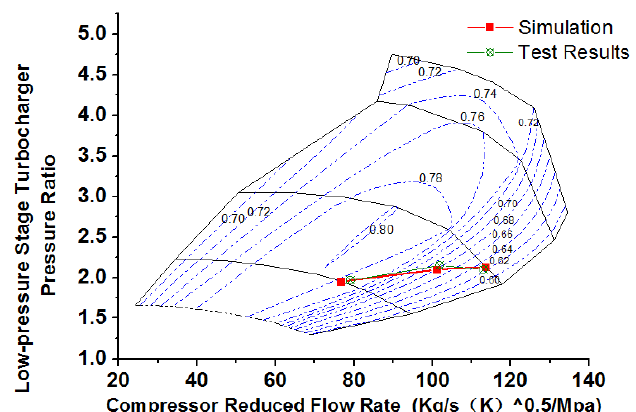
Figure 10. Comparison between low-pressure stage simulation and test results.